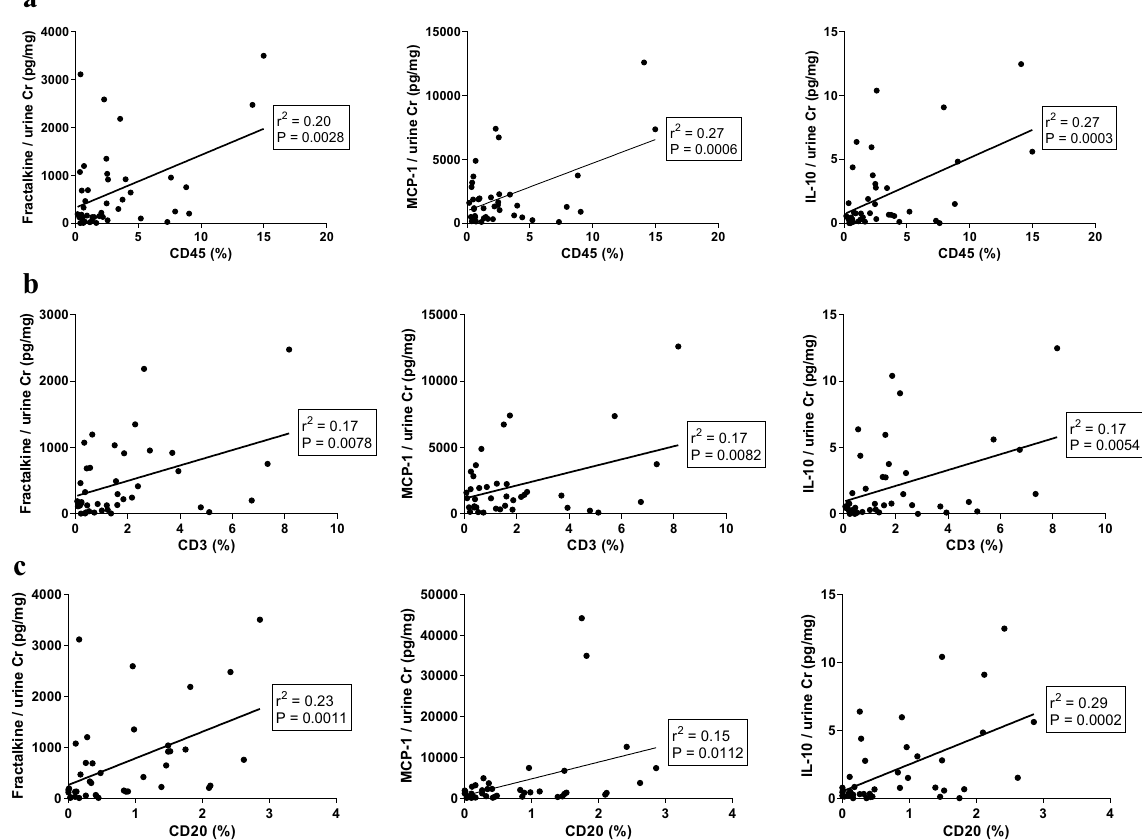
Figure 5. Correlation between intrarenal leukocytes infiltration and urinary cytokines/chemokines. ( a ) Urinary fractalkine, MCP-1, and IL-10 showed positive correlation with infiltration of total leukocytes expressing CD45. ( b ) Urinary fractalkine, MCP-1, and IL-10 showed positive correlation with intrarenal T cells expressing CD3. ( c ) Urinary fractalkine, MCP-1, and IL-10 showed positive correlation with intrarenal B cells expressing CD20. CD clusters of differentiation, Cr creatinine, IL interleukin, MCP-1 monocyte chemoattractant protein-1.